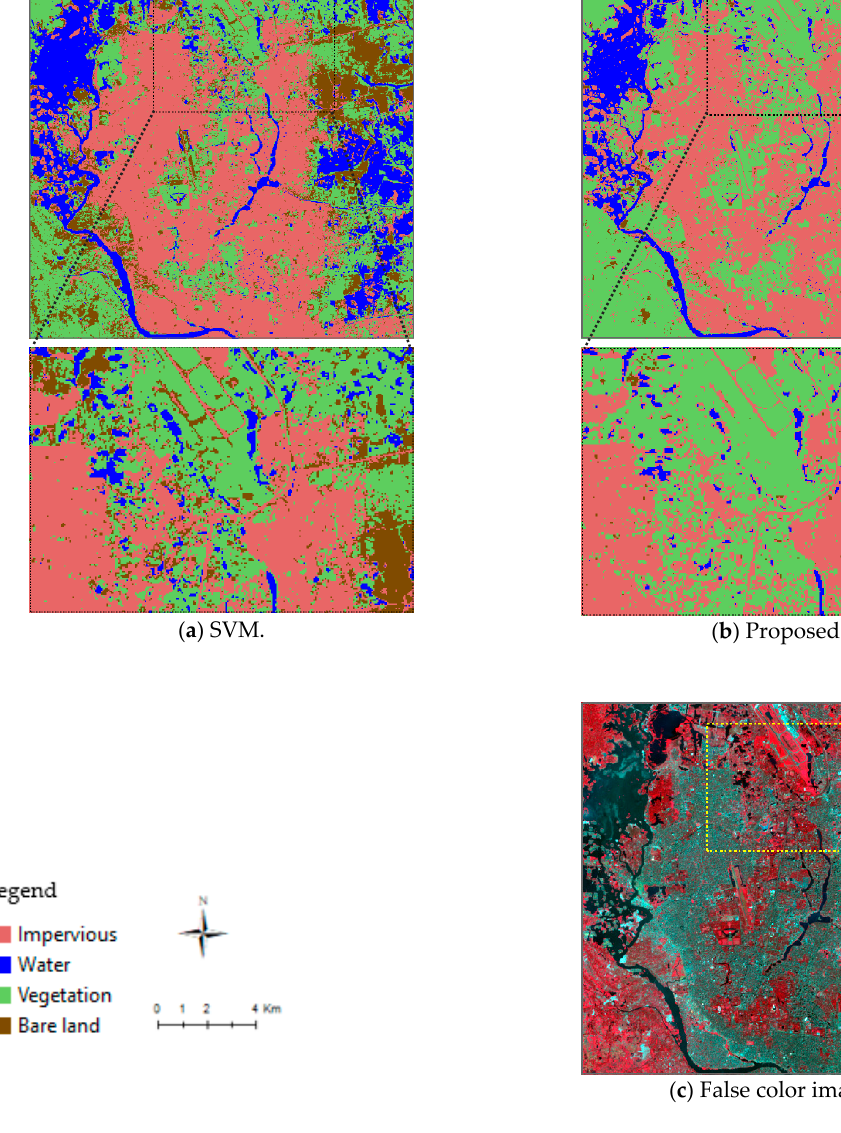
Figure 17. Classification of land cover in Dhaka. Table 7. Accuracy of results for the Hong Kong dataset.